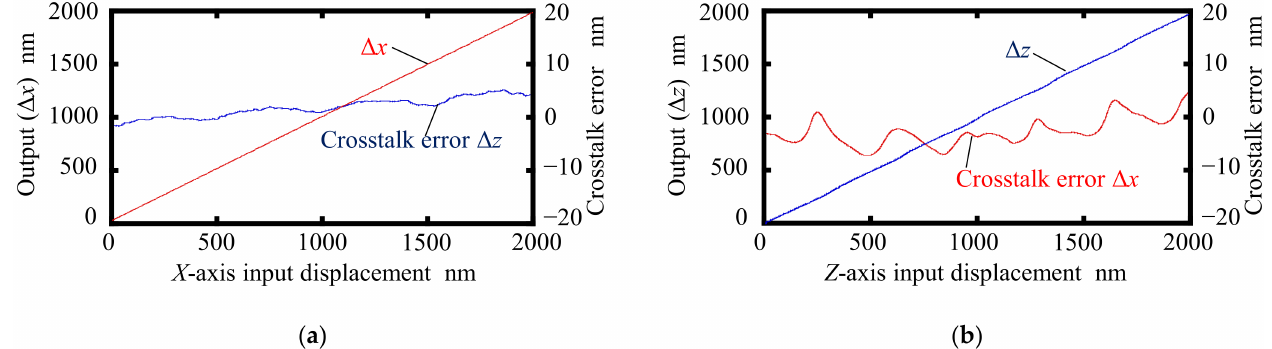
Figure 8. Crosstalk errors: ( a ) Readings of ∆ x and ∆ z when the X -directional displacement was applied; ( b ) Readings of ∆ x and ∆ z when the Z -directional displacement was